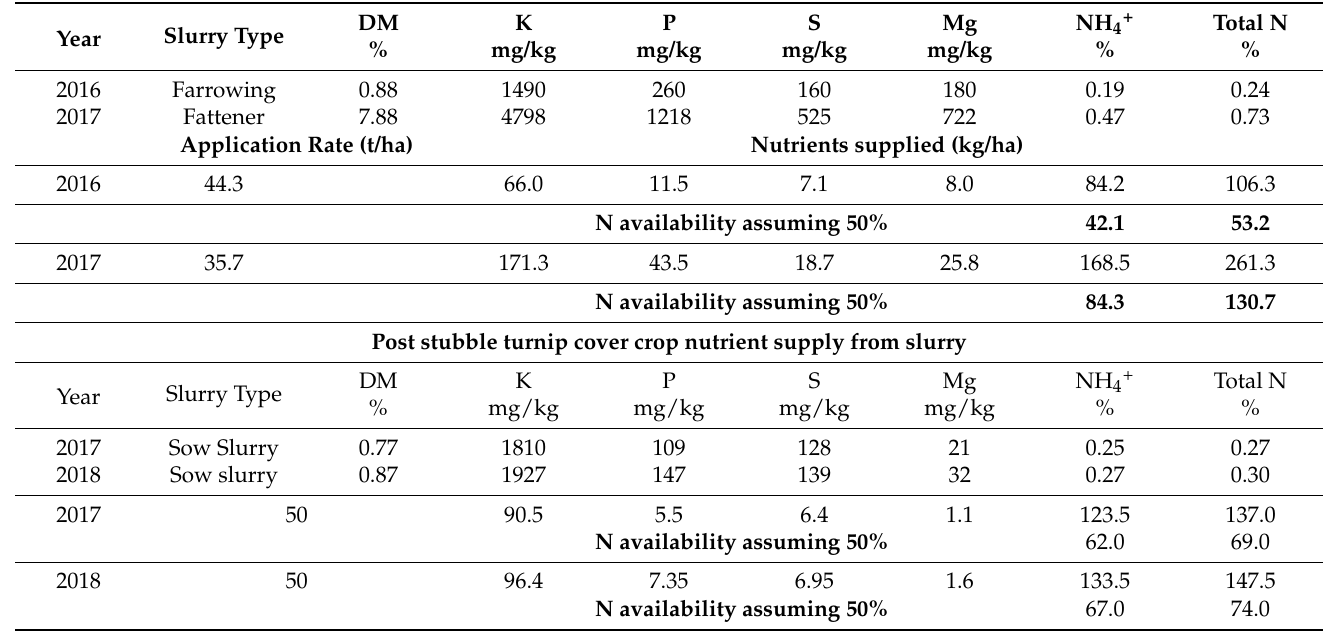
Table A1. Nutrients supplied from slurry prior to sowing the stubble turnips.